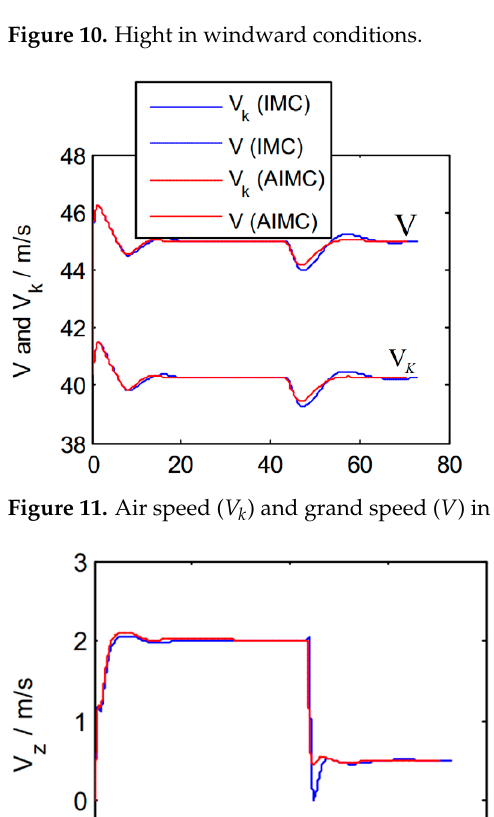
Figure 13. Pitch angle in windward conditions.